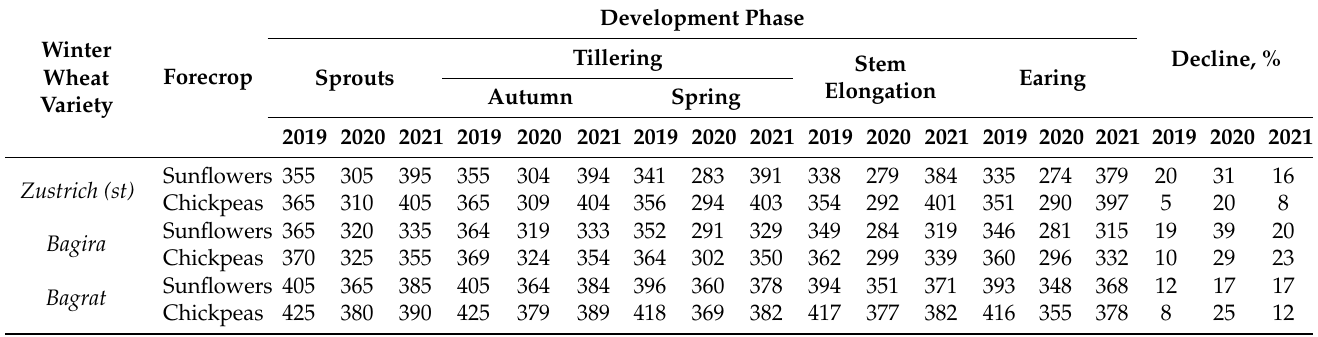
Table 5. Plant density of winter wheat, pcs/m 2 .